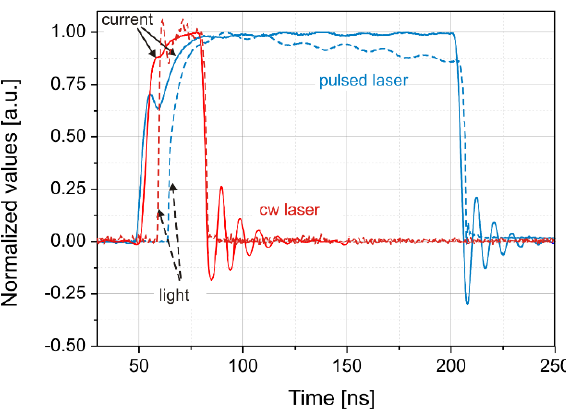
Figure 9. Laser light power and driving current pulses for pulsed and cw lasers.